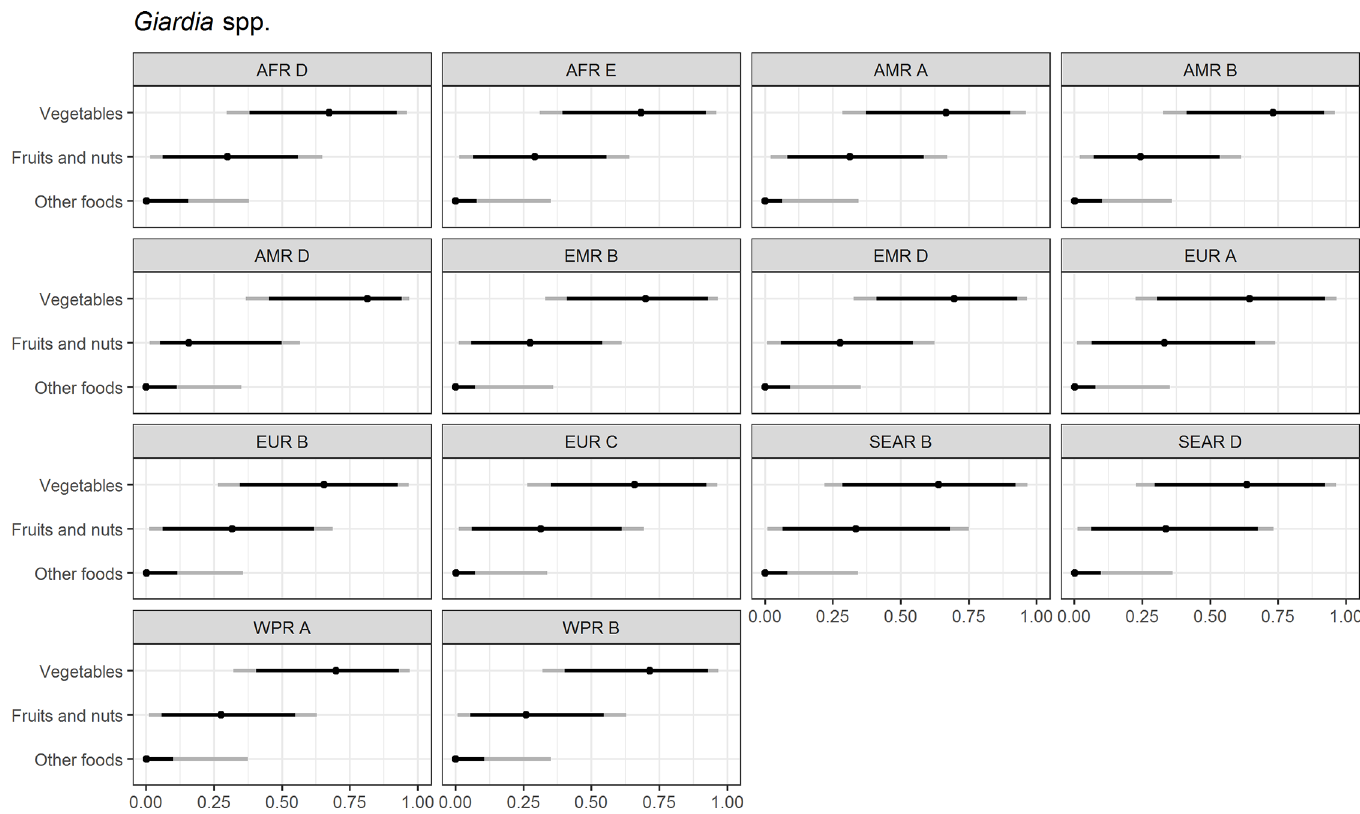
Fig 9. Giardia spp. Proportion of foodborne disease attributable to specific foods: Median estimate, and 90% and 95% uncertainty intervals by parasite and subregion. “Small ruminants’ meat” was listed as “Goat, lamb and other small ruminants’ meat” in the expert elicitationinstrument. The X-axis labels are percentages. The dot representsthe median estimate; the dark black line, the 90% uncertainty interval; and the gray line the 95% uncertainty interval.